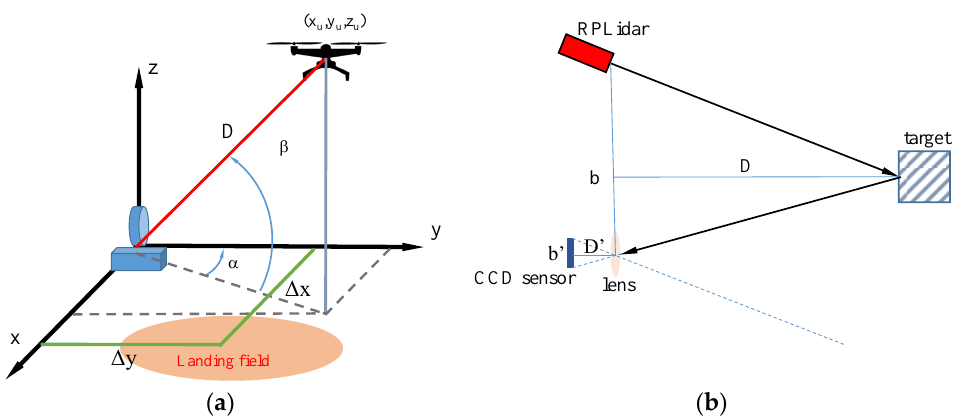
Figure 2. ( a ) UAV position estimation by LiDAR measurements; ( b ) laser triangulation principle. Denoting with 𝑈𝐿̅̅̅̅ the slant range (or LOS, Line Of Sight) of the UAV from the landing center, and with 𝐿𝑅̅̅̅̅ the ground range, we have: